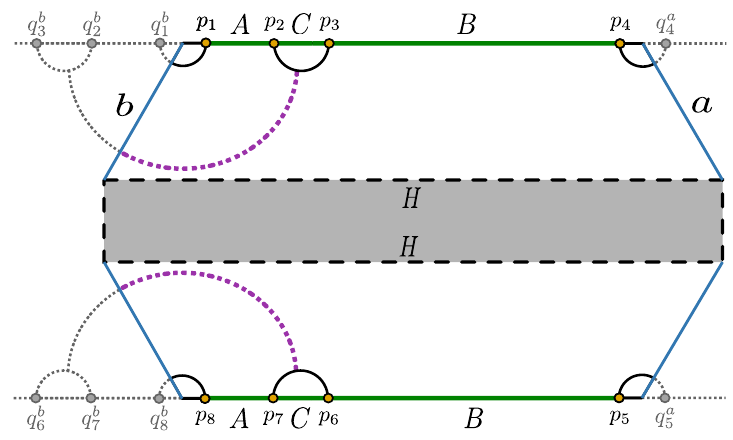
Figure 21 . The endpoints of the intervals A and B and the image points in the two BCFT 2 copies are identified similarly as in figure 20. The other points q b points of p 2 and p 3 respectively with respect to the b -boundary. Also q b the image points of p 6 and p 7 respectively with respect to the b